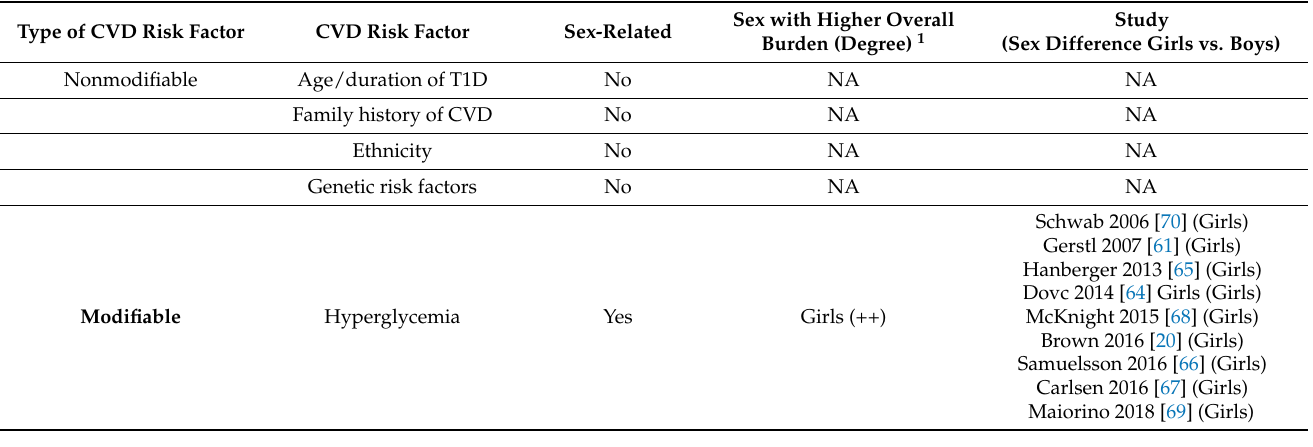
Table 1. Types of cardiovascular risk factors and their relation to sex in children and adolescents with type 1 diabetes. Type of CVD Risk Factor CVD Risk Factor Sex-Related